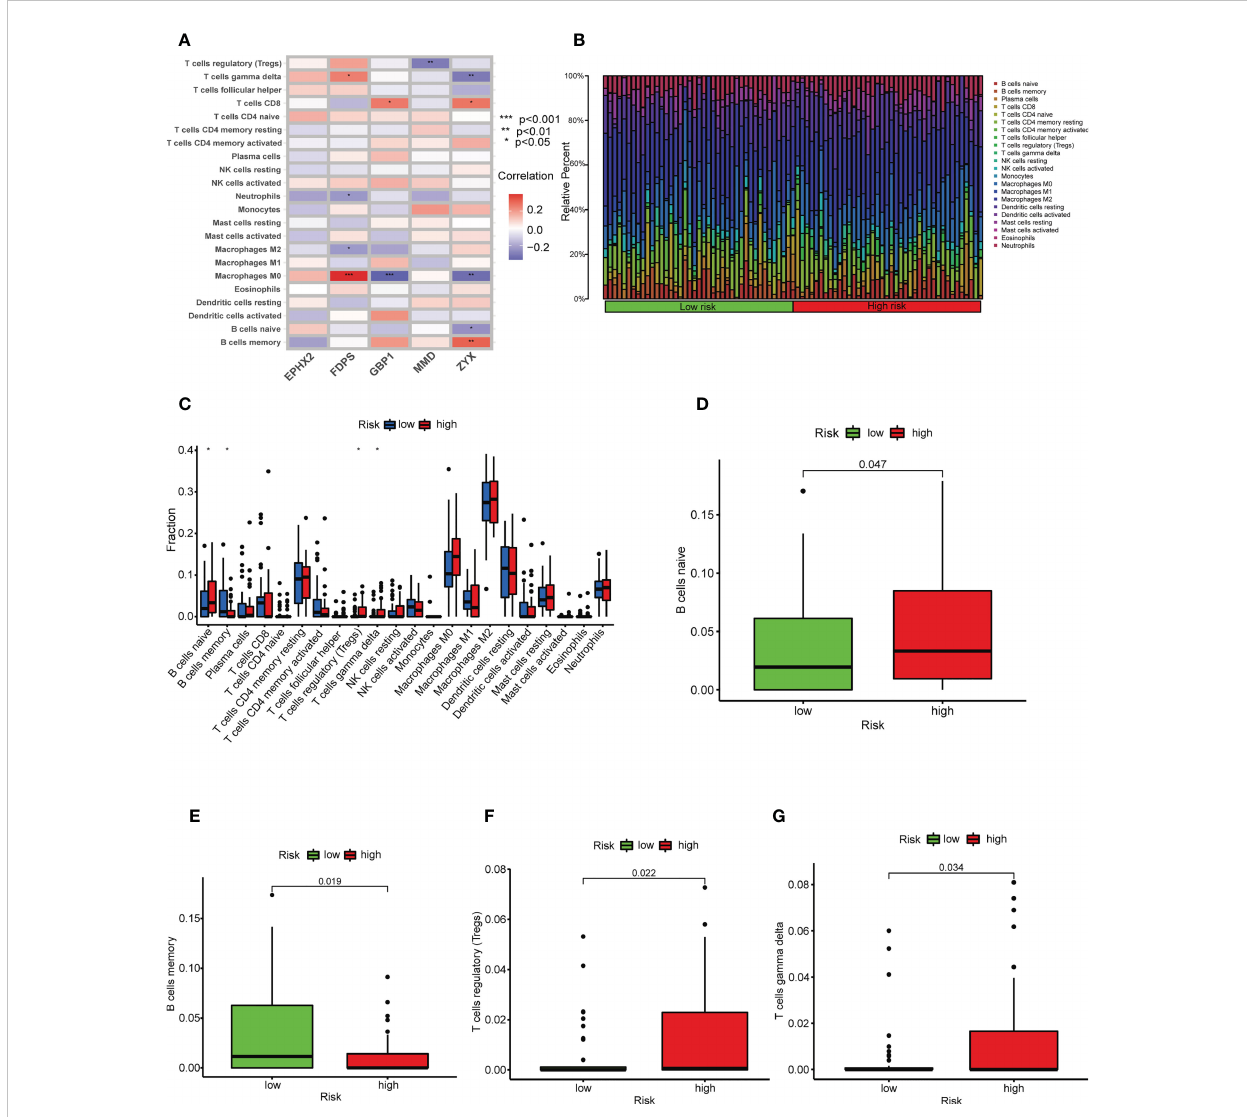
FIGURE 5 TILscore-associated immune landscape. (A) Heat map of the correlation between the 5 genes of TILscore and the abundance of 22 immune cell in fi ltrates. (B) Heat map showing the in fi ltration abundance of 22 immune cell species in different risk groups. (C) Box plots showing differences in immune cell in fi ltration by risk group. Differences among naive B cells (D) , memory B cells (E) , Treg cells (F) and gamma delta T cells (G) in the high- risk and low-risk groups. *p < 0.05; **p < 0.01; ***p <